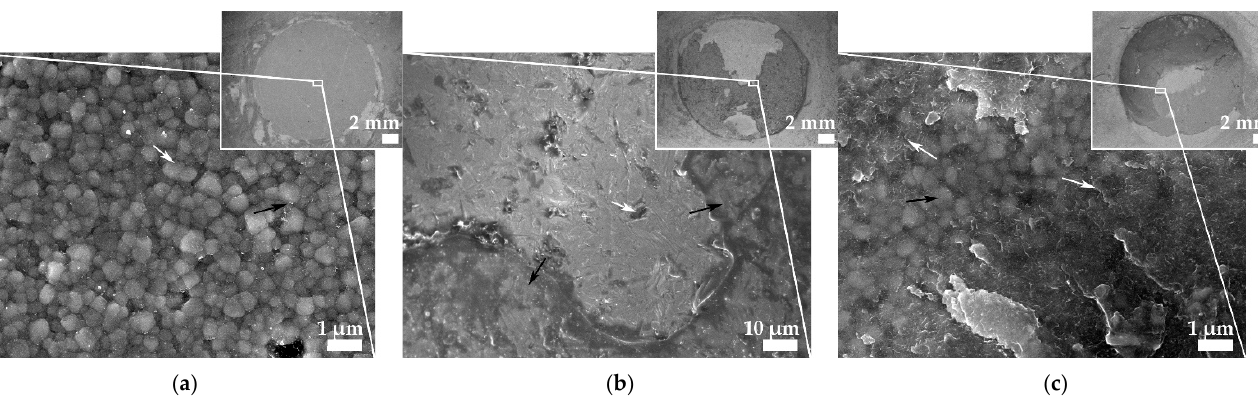
Figure 3. Mean percentages of assigned failure modes after shear bond testing of non-cycled (NC) and cycled (TC) groups.